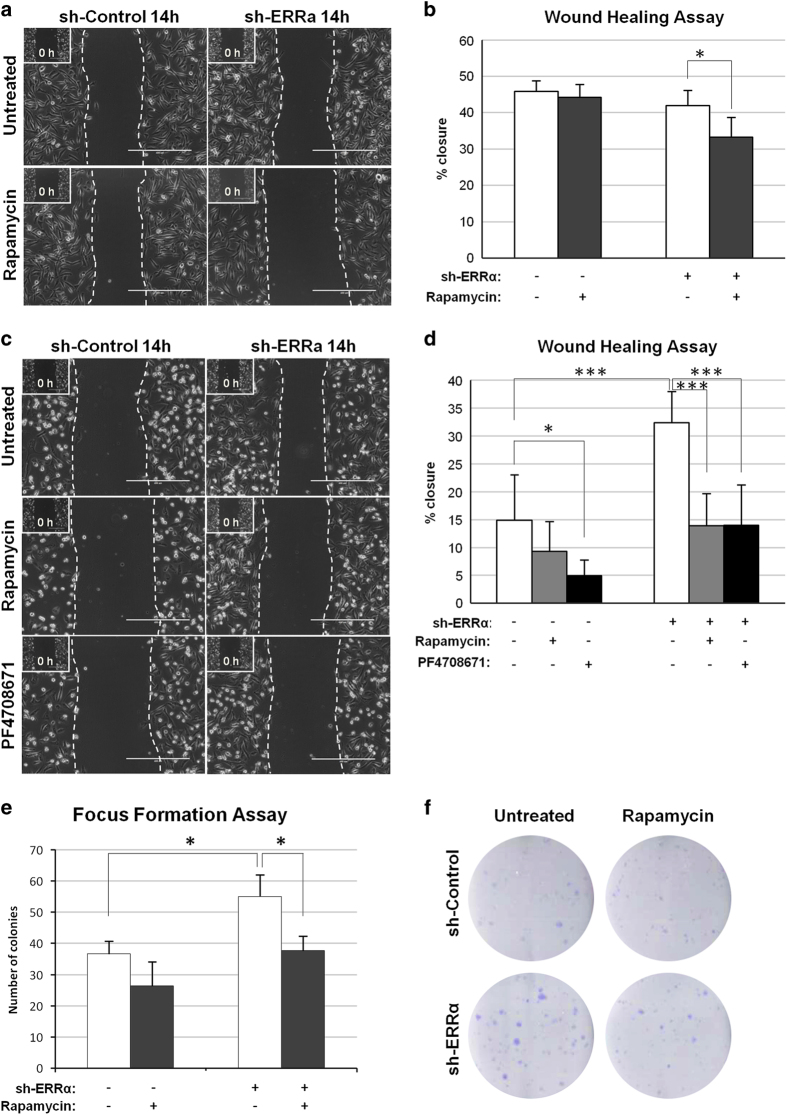
Modulation of S6K1 activity affects cell migration and transforming ability of cells with stable ERRα knockdown. (a) Stable MDA-MB-231 control or ERRα knockdown cells were seeded in 12-well plate in complete DMEM media and grown to confluency in monolayer overnight. The following day, cells were placed in reduced (1%) serum media and following 8–10 h of pretreatment with 20 nM rapamycin, wound/scratch was generated. Wound closure was measured 14 h post incubation (b) Quantification of the wound healing assay from a was performed and graphed using paired Student’s t-test. * represents P<0.05. ** represents P<0.01. *** represents P<0.001. (c) Stable MDA-MB-231 control or ERRα knockdown cells were seeded in 12-well plate in complete DMEM media and grown to confluency in monolayer overnight. The following day, cells were placed in low glucose media and following 8–10 h of pretreatment with either 20 nM rapamycin or 20 μM PF4708671, wound/scratch was generated. Wound closure was measured 14 h post incubation. (d) Quantification of the wound healing assay from c was performed and graphed using paired Student’s t-test. * represents P<0.05. ** represents P<0.01. *** represents P <0.001. (e) Stable MDA-MB-231 control cells or ERRα knockdown cells were seeded in six-well plate in complete DMEM media, and allowed to attach overnight. The media was then changed to reduced serum DMEM, and cells were treated with 20 nM rapamycin for 10 days. Foci were subsequently fixed with methanol and stained with crystal violet. Colonies with >50 cells were counted and graphed using paired Student’s t-test. * represents P<0.05. (f) Cells were treated as described in e and images were acquired using EVOS FL Auto microscope under ×4 magnification.